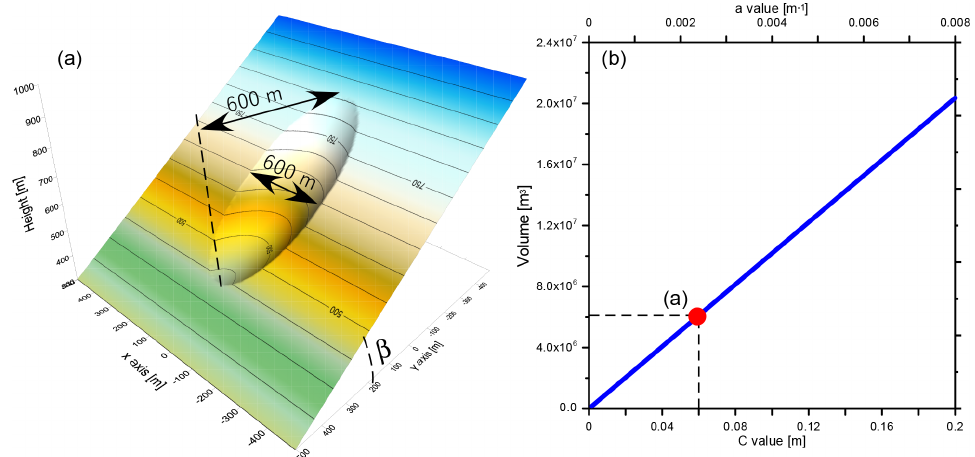
Figure 3. Example of volume values for an elliptic shape and the volume changes with a and C values. (a) Example of the SLBL for C = 0 . 06m corresponding to a = 0 . 00240m − 1 and a a L = 00096m − 1 for a volume of 6 . 1073 × 10 6 m 3 . (b) Relationship of a and C values with volume for L rh = 600m and the width w =